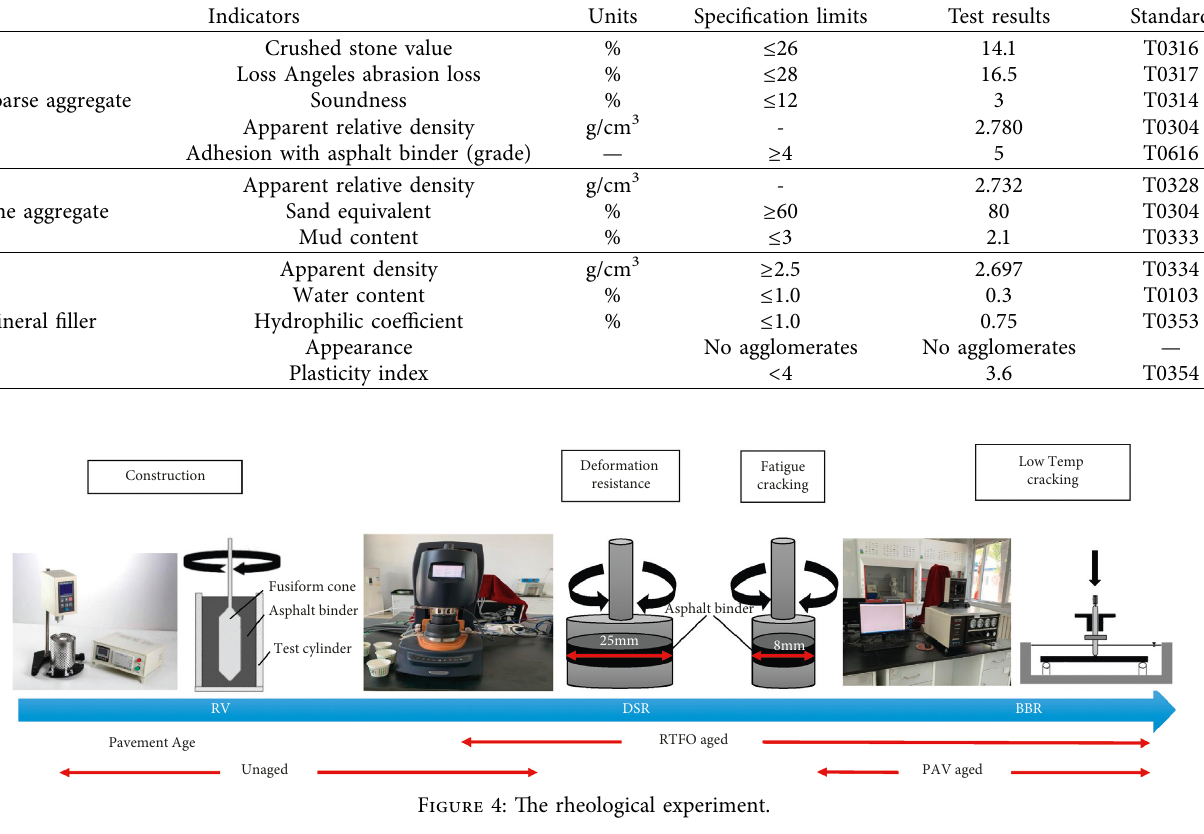
Table 4: Properties of mineral filler, coarse, and fine aggregate.